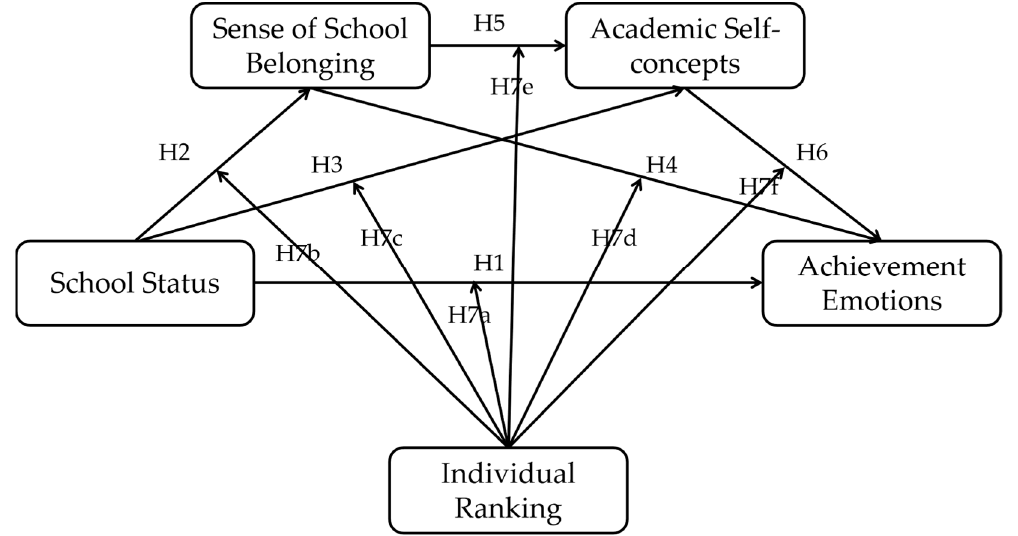
Figure 2. A diagram of our final research model—a moderated serial mediation model.